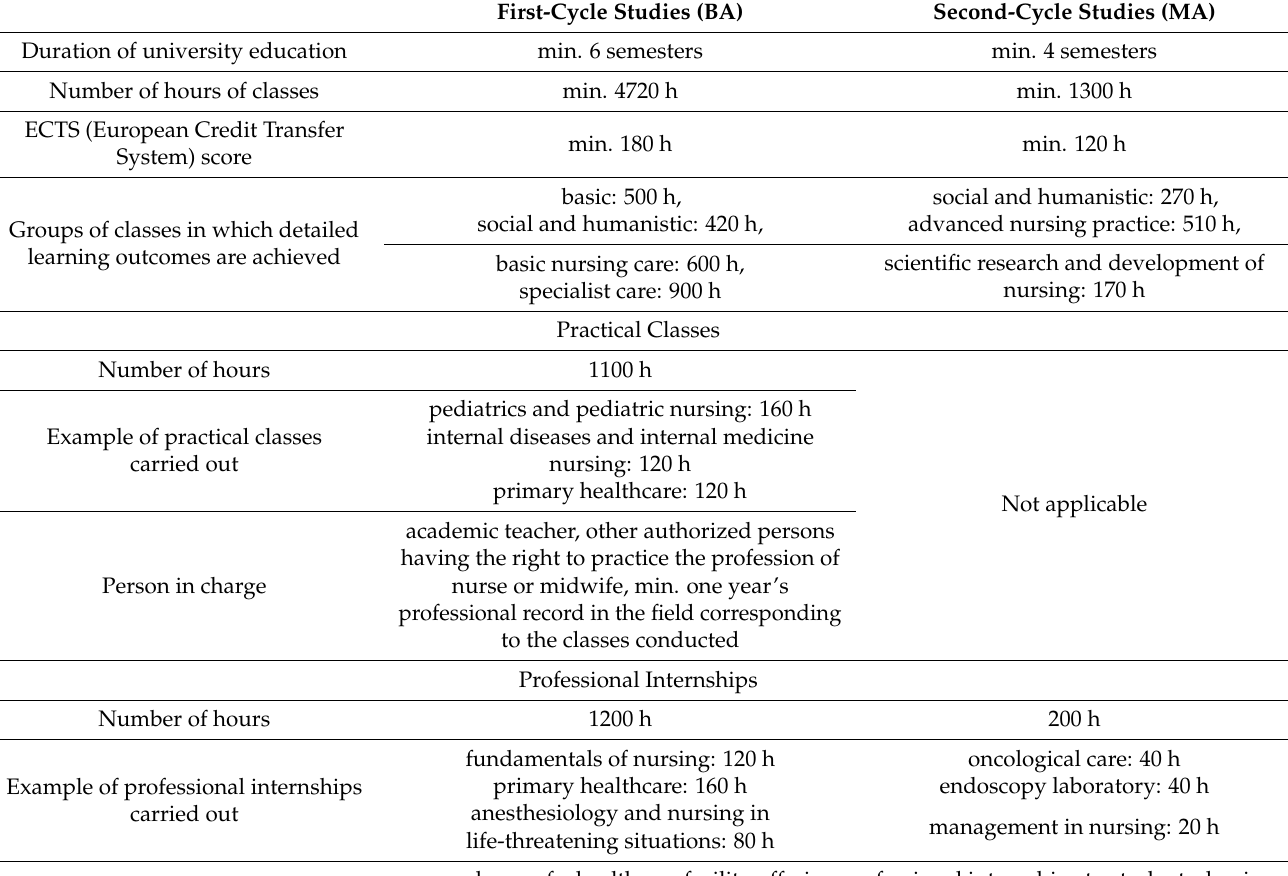
Table 1. Characteristics of first- and second-cycle studies in the field of nursing